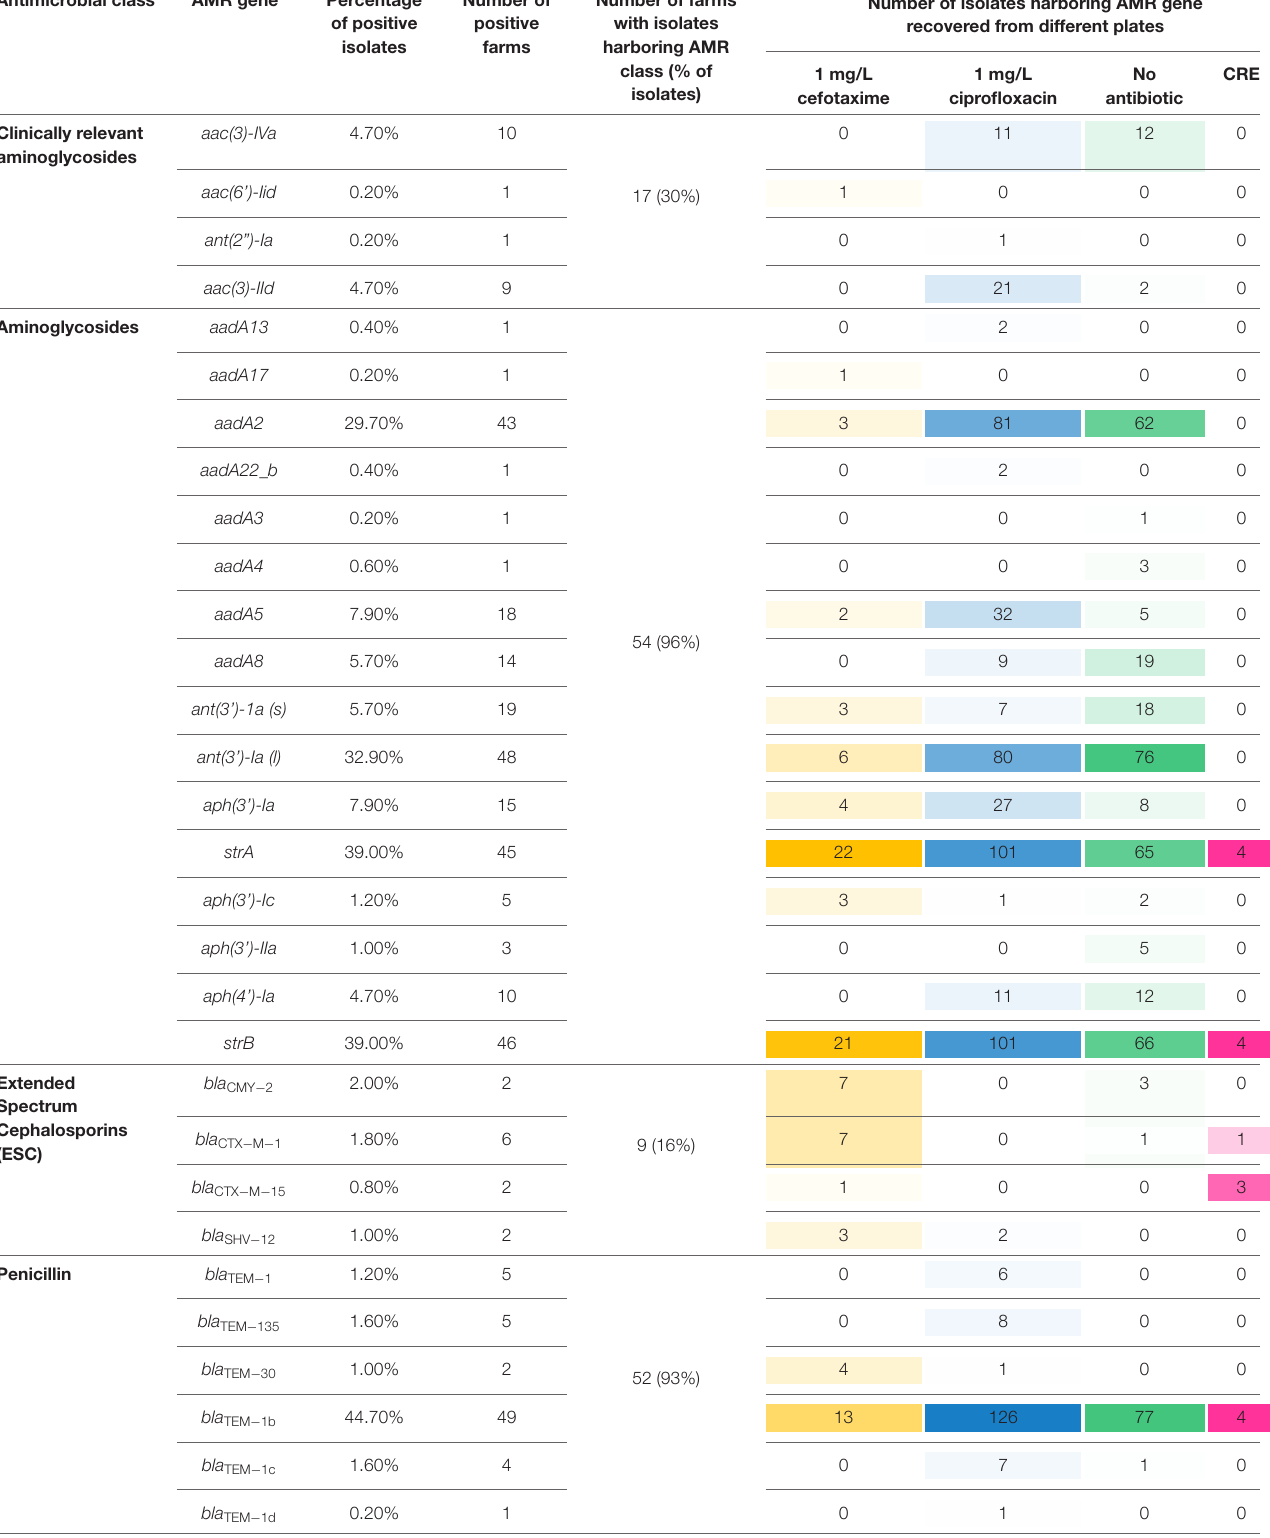
TABLE 1 | Summary of antimicrobial resistance genes from different classes identified in Escherichia coli isolates.